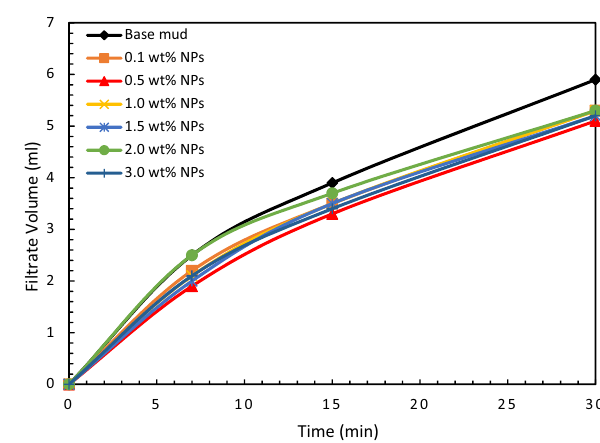
Fig. 7 Effect of concentrations of NPs on yield point